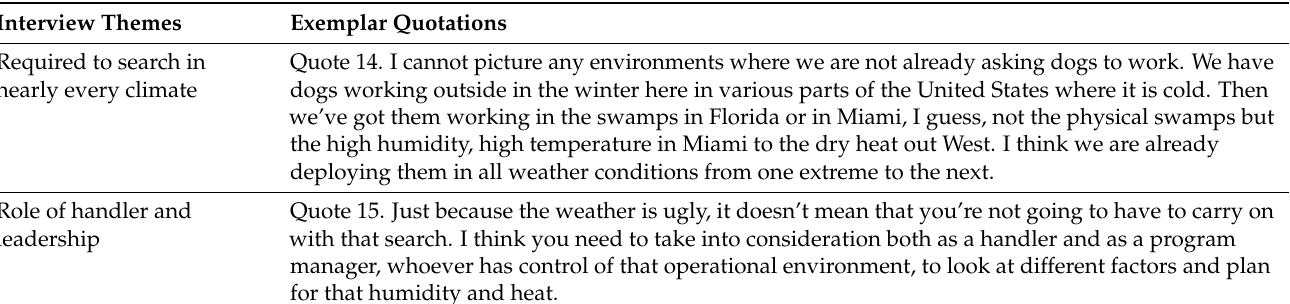
Table 4. Climate environment interview themes and exemplar